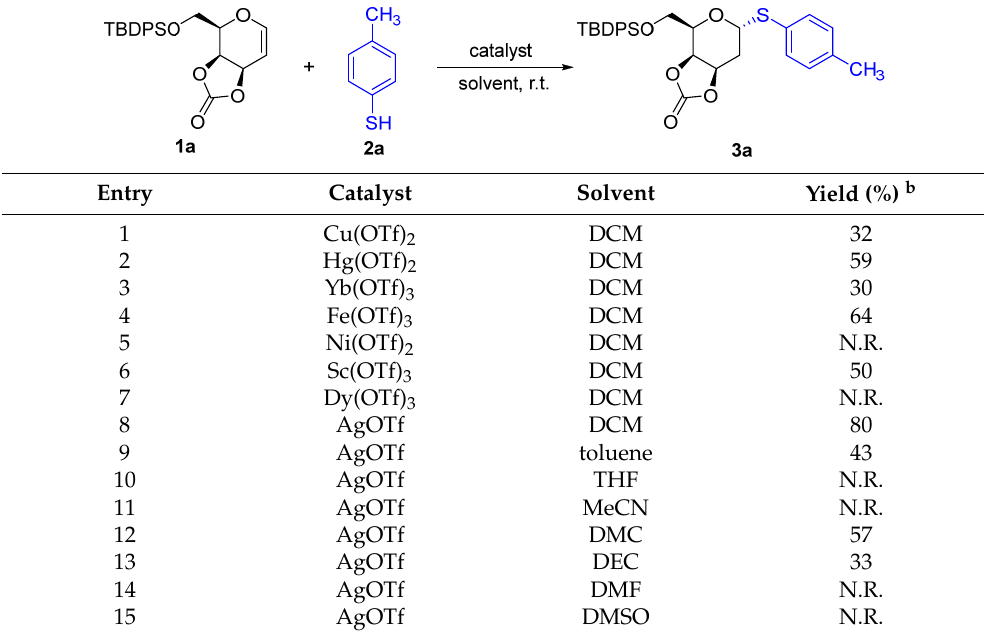
Table 1. Condition optimization for the 2-deoxythioglycosylation a .